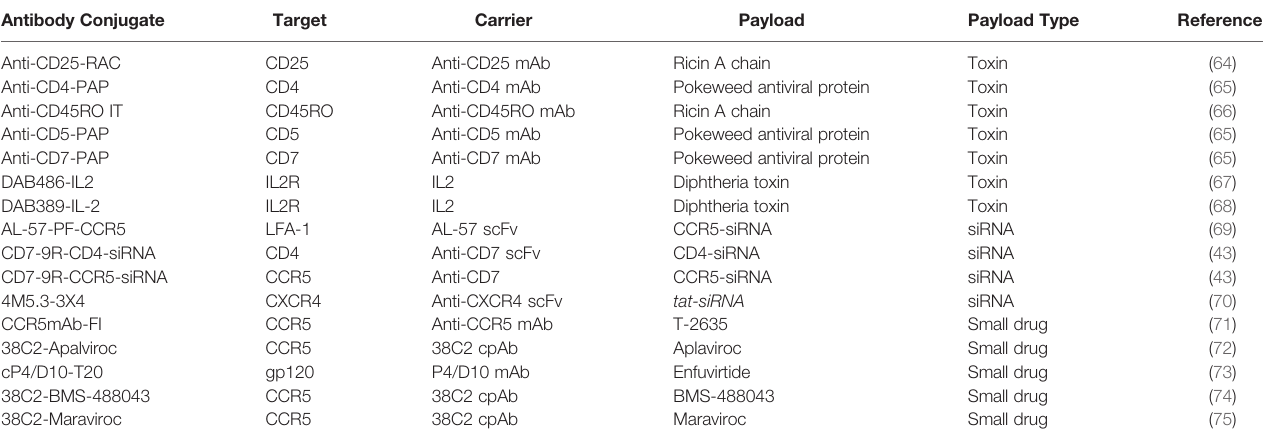
TABLE 3 | Host-directed antibody conjugates. Antibody